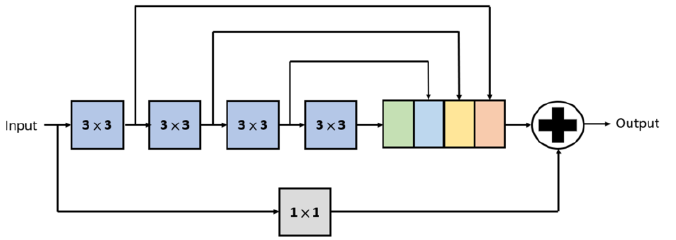
Figure 2. An illustration of an inception-like block.